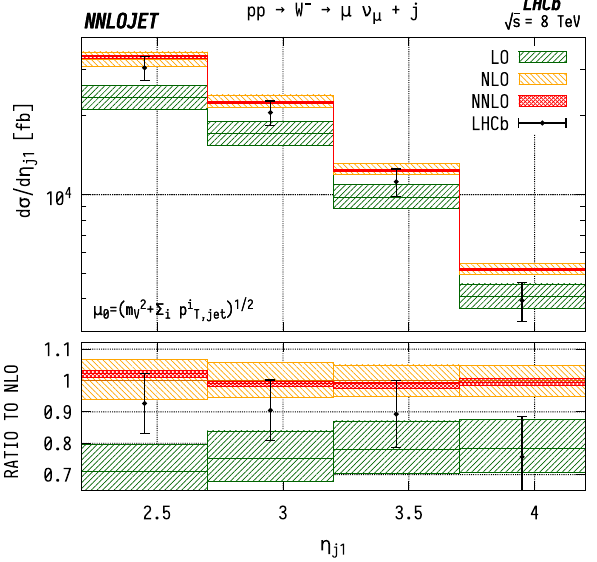
Fig. 8 Cross section differential in the pseudorapidity η of the leading jet for Z production. See Fig. 3 for details